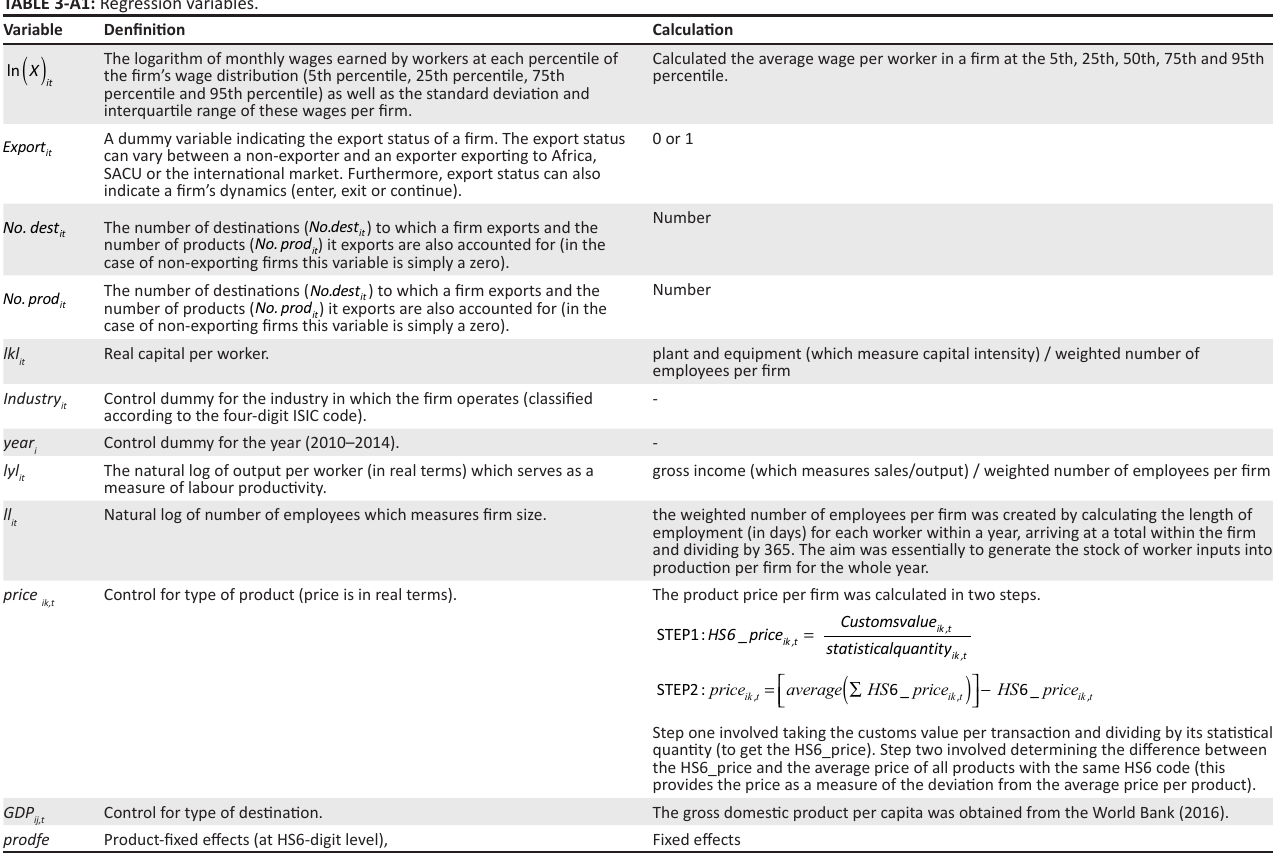
TABLE 3-A1: Regression variables. Variable Denfinition